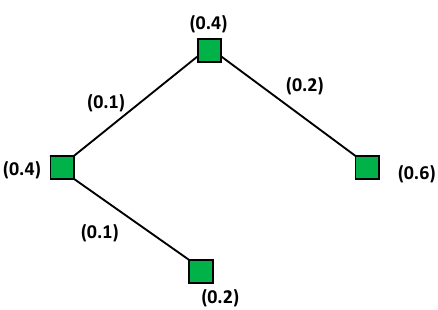
Figure 2. Complement of FG depicted in Figure 1. Figure 2 . Complement of FG depicted in Figure 1 . Figure 2 . Complement of FG depicted in Figure 1 .